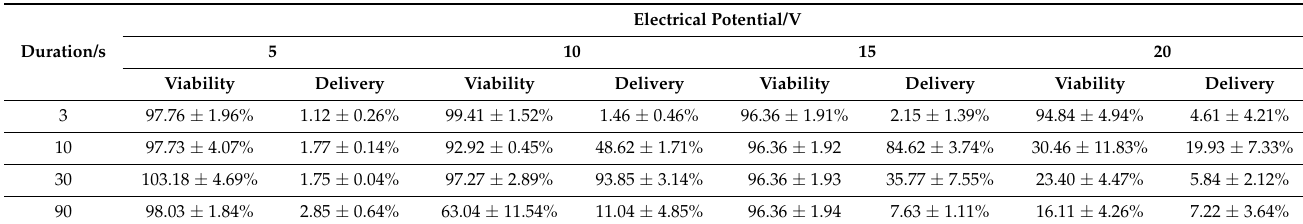
Table 1. The data of cell viability and PI delivery efficiency under each group of nanostraw- electroporation conditions.